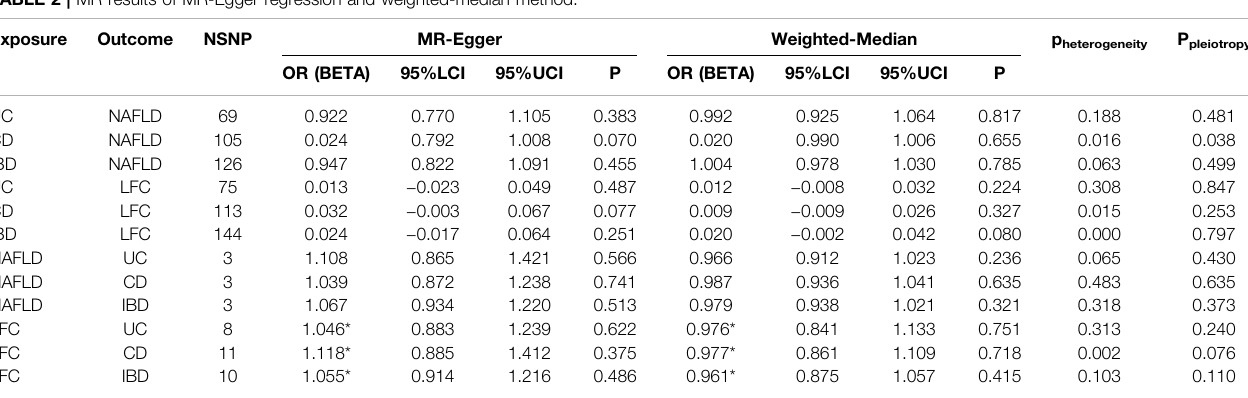
TABLE 2 | MR results of MR-Egger regression and weighted-median